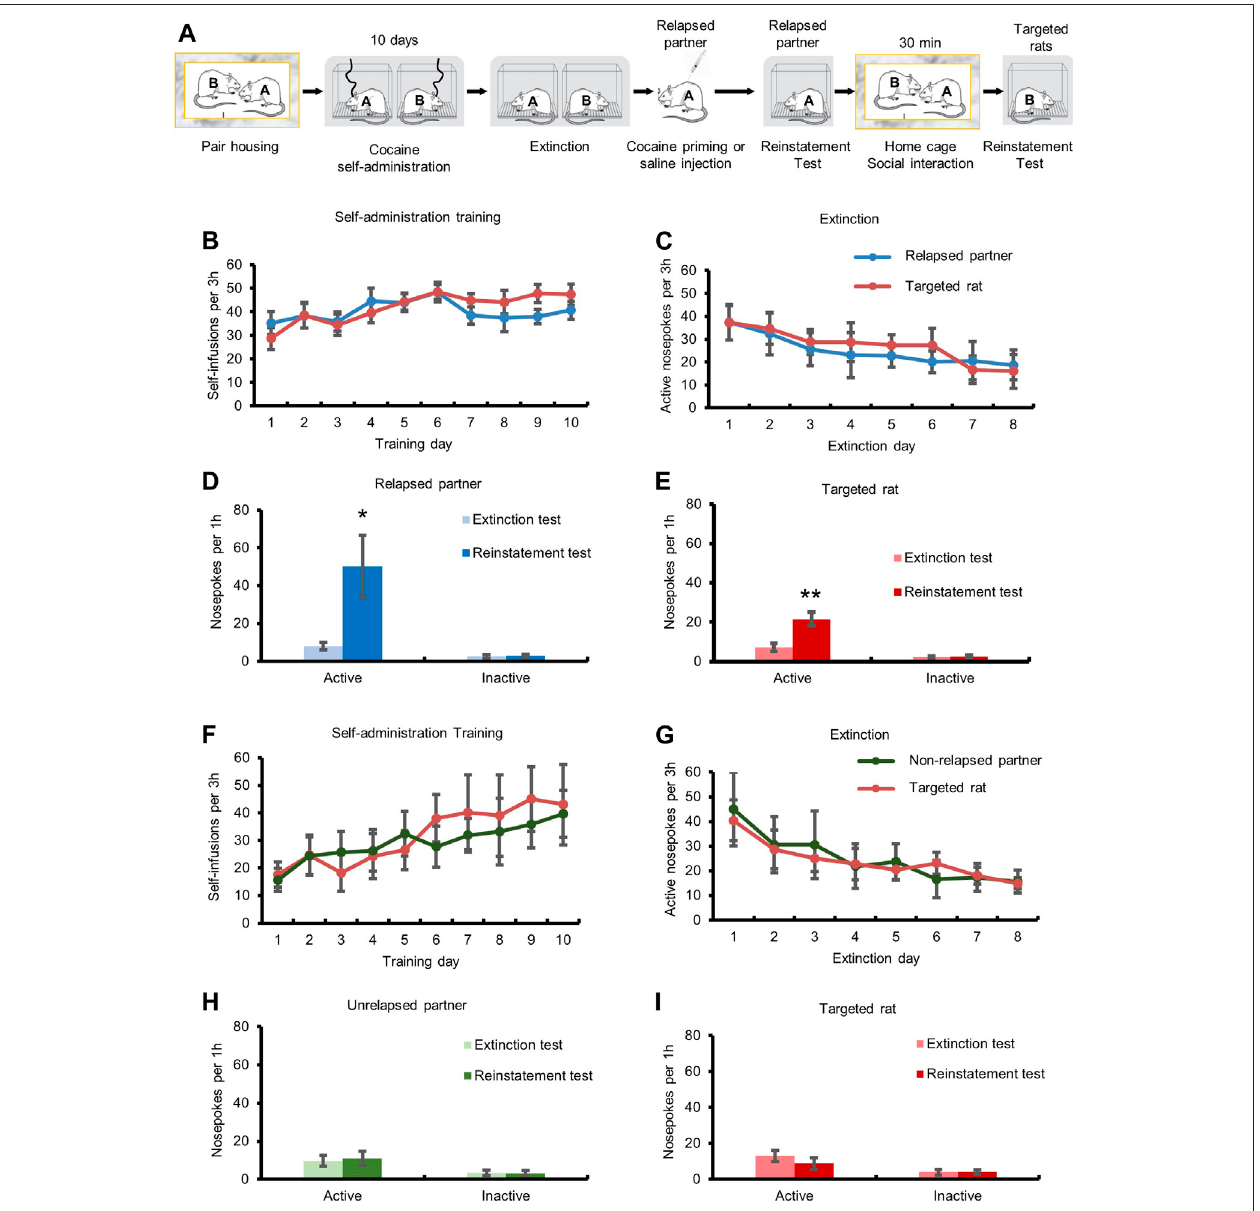
FIGURE 1 | Social interaction with relapsed partner induced relapse to cocaine seeking behavior. (A) Experimental timeline. (B,F) Targeted rats and partners acquired cocaine self-administration training. (C,G) Drug-seeking behavior of targeted rats and partners was extinguished. (D) Cocaine injection triggered drug seeking behavior. (E) Drug-seekingbehavioroftargeted ratswasincreasedafter social interaction with relapsed partner (Dataareshown asmean ± SEM. ** p < 0.01,compared with extinction test. n (cid:1) 11). (H) Saline injection had no effect on drug seeking behavior. (I) Drug-seeking behavior of targeted rats had no change after social interaction with unrelapsed partner (Data are shown as mean ± SEM. n (cid:1) 7).